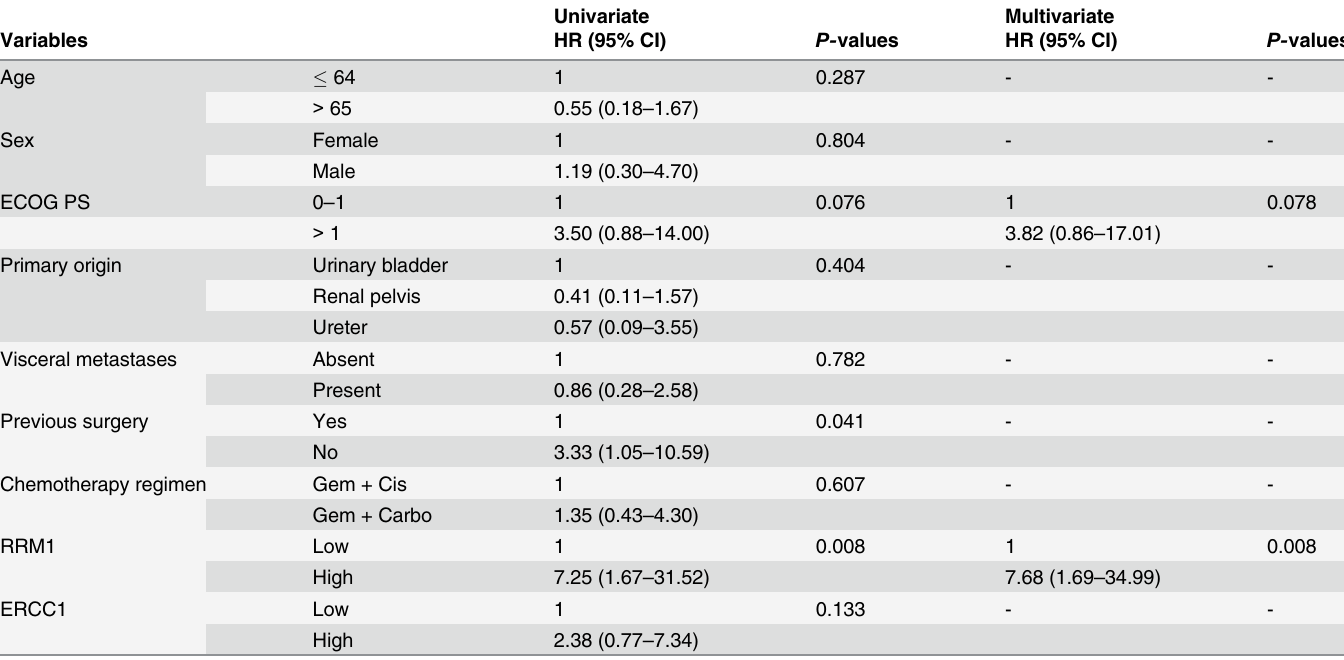
Table 3. Univariate and Multivariate Logistic regression analysis for clinical